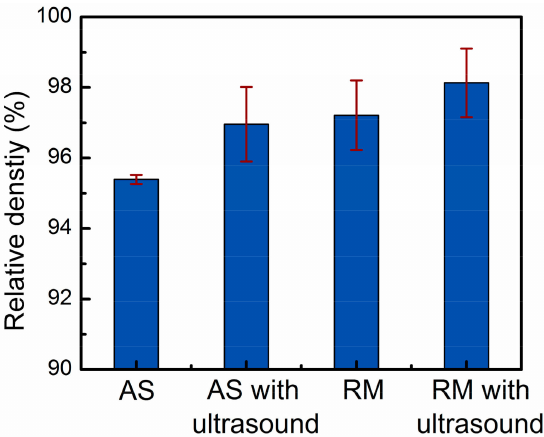
Figure 3. Relative density results of Al-12Si samples prepared by four di ff erent